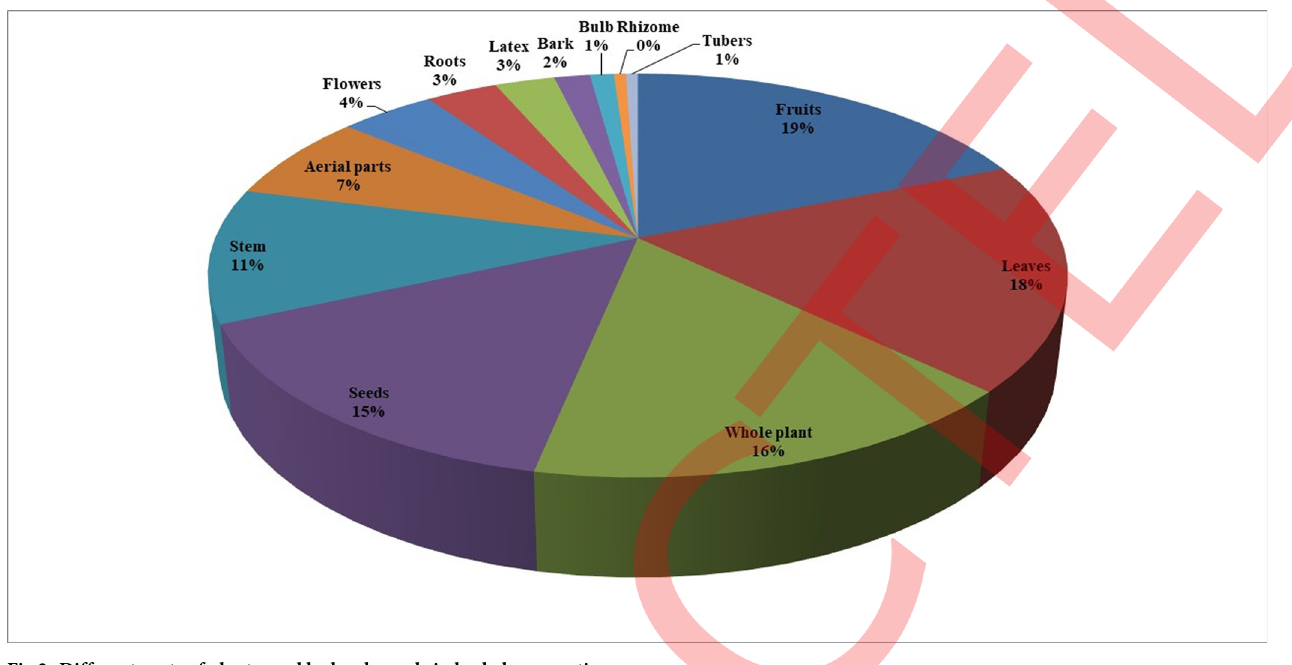
Fig 2. Different parts of plants used by local people in herbal